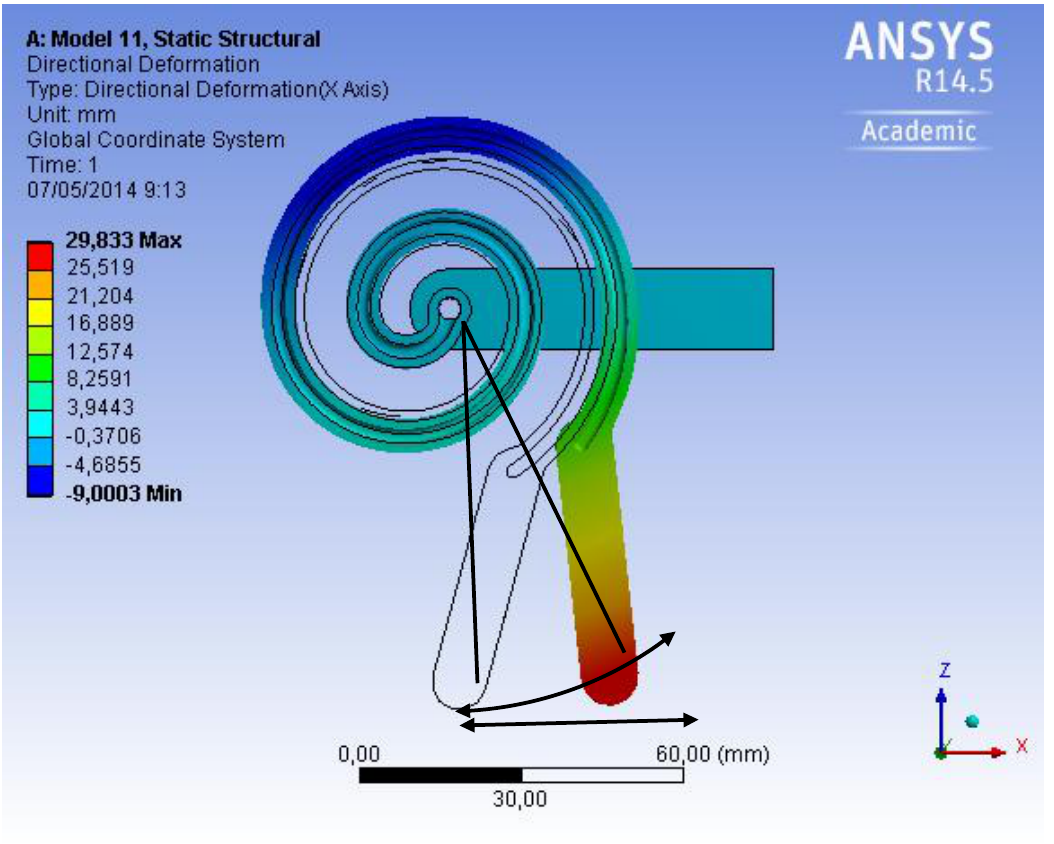
Figure 3. AM actuators with two degrees of freedom, rotation represented in the figure and small horizontal translation.